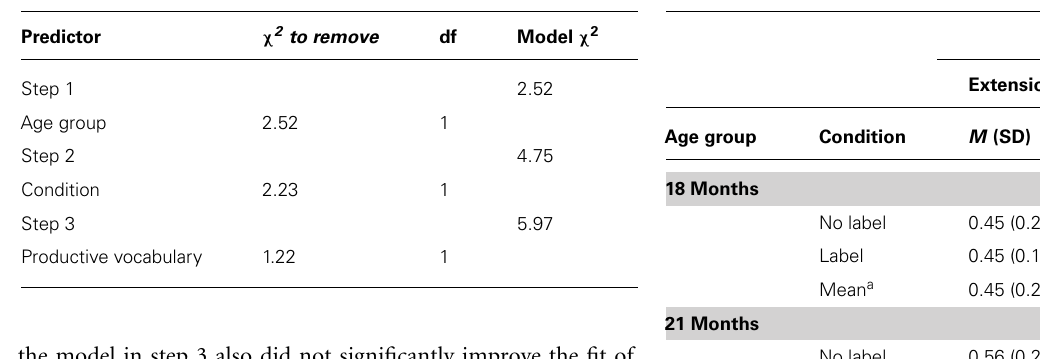
Table 7 | Mean proportion examination times for the target object by condition and age group (extension and generalization